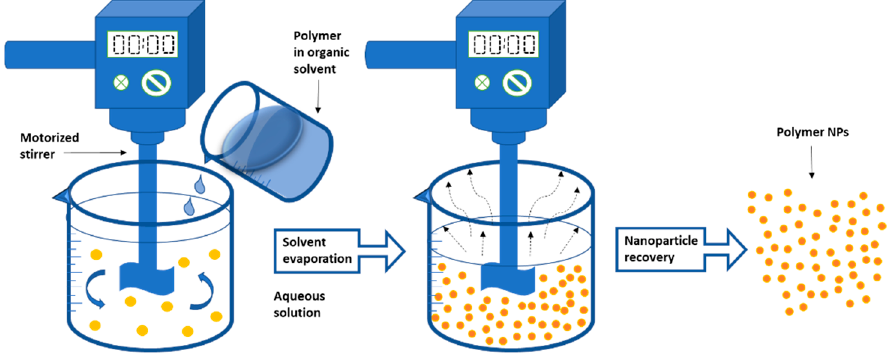
Figure 3. The emulsification-solvent evaporation technique is depicted schematically. Adapted from Wang et al. (2016) [78].